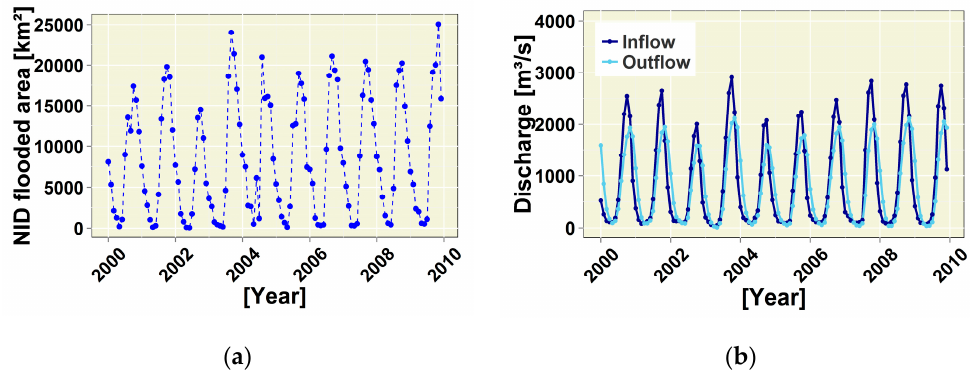
Figure 3. ( a ) Monthly flooded surface area estimated using SeaWinds data in the NID over the